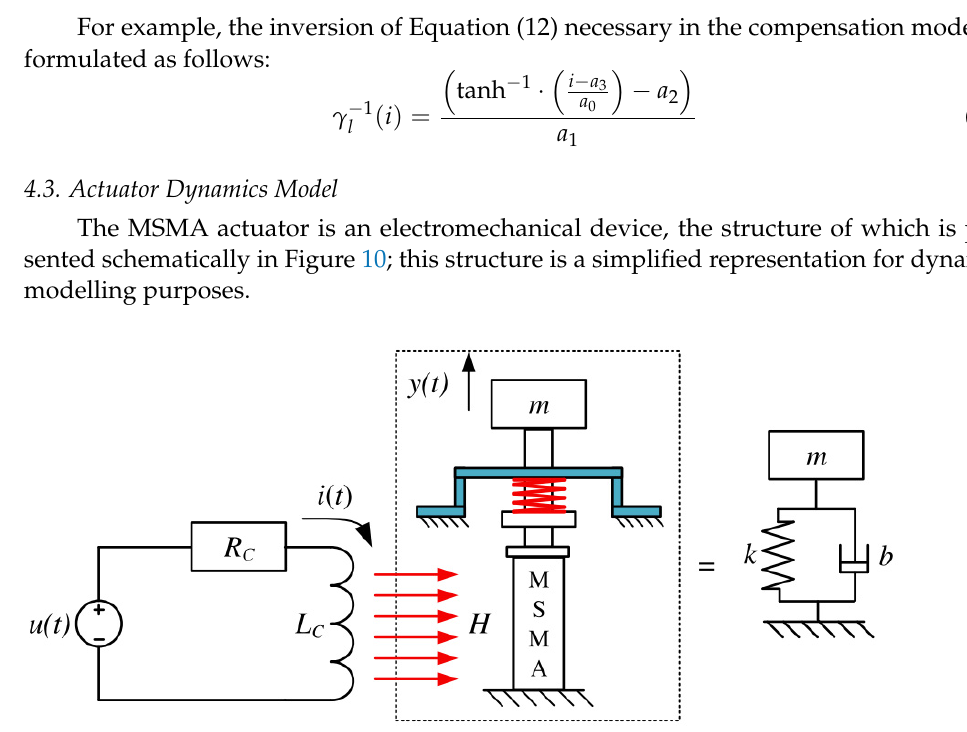
Figure 10. Schematic representation of the electromechanical structure of the MSMA actuator, where: u ( t )—supply voltage, R c —coil resistance, L c —coil inductance, i ( t )—current, y ( t )—mass displacement, H —magnetic field strength, m —mass, b —resultant damping coefficient, and k —resultant spring constant.